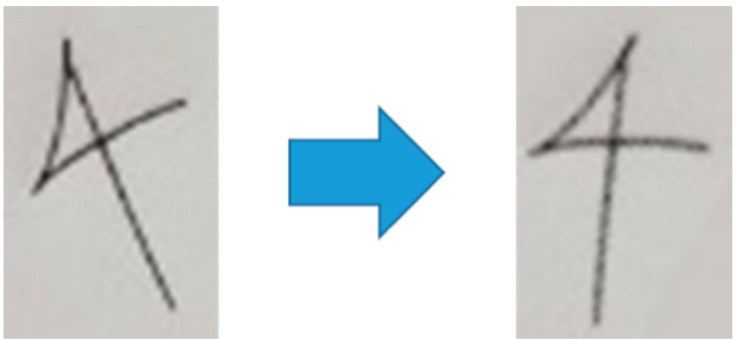
Figure 10. Estimation of the diagonal line part of “4”.